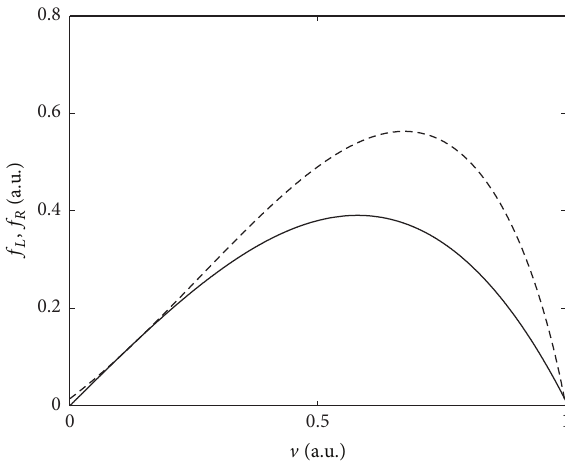
Figure 5: Bifurcation diagram of the bistable pathway model (9) acting as a switch for a particular value of 𝐾 when varying the degree of asymmetry. The stationary solutions 𝑥( st ) are plotted versus the control parameter values 𝛼 . The solutions 𝑥( st ) were computed from (18), (19), (20), and (21). Solid line: asymptotically stable fixed points of the state 𝑥 (low), 𝑦 (high). Dotted line: unstable fixed points in the bistable parameter domain. Dashed line: asymptotically stable fixed points of the state 𝑥 (high), 𝑦 (low). Parameters: 𝐾 = 0.01 , 𝐴 = 0.5 , and 𝐵 = 3.5 .